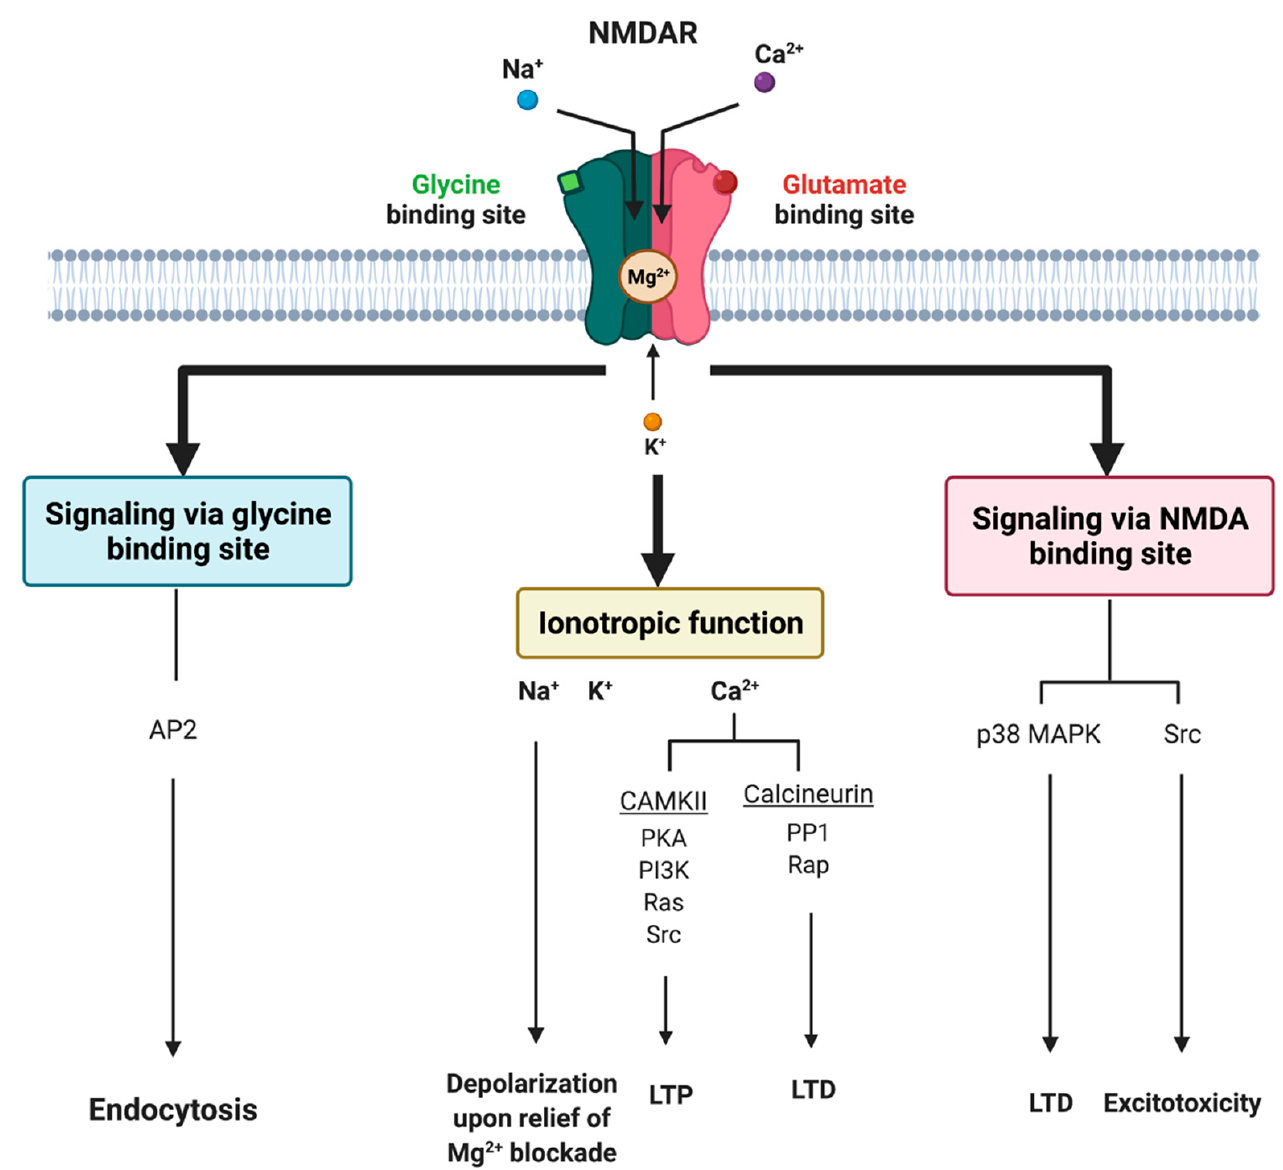
Figure 1. Tripartite signaling of N-Methyl-D-Aspartate Receptor (NMDAR). This model illus-